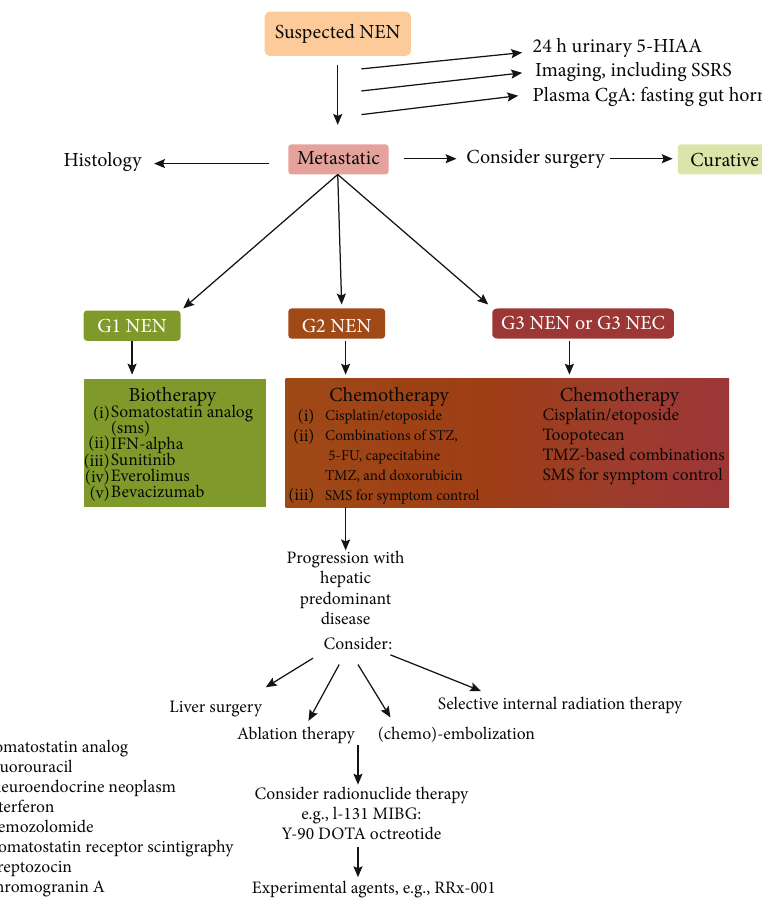
Figure 5: Di ff erent treatment modalities that can be used in the management of NETs